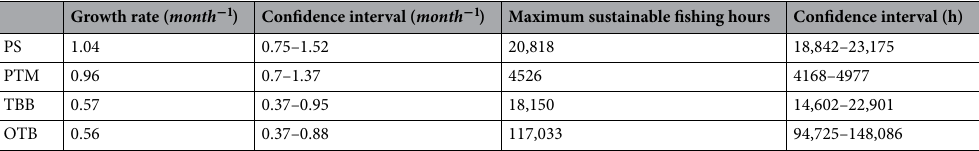
Table 3. Monthly growth rates and maximum sustainable hours per gear (and confidence intervals) estimated through AMSY. Acronyms refer to distinct fleets using a purse seine (PS), a pelagic pair trawl (PTM), a beam trawl (TBB) or a bottom otter trawl